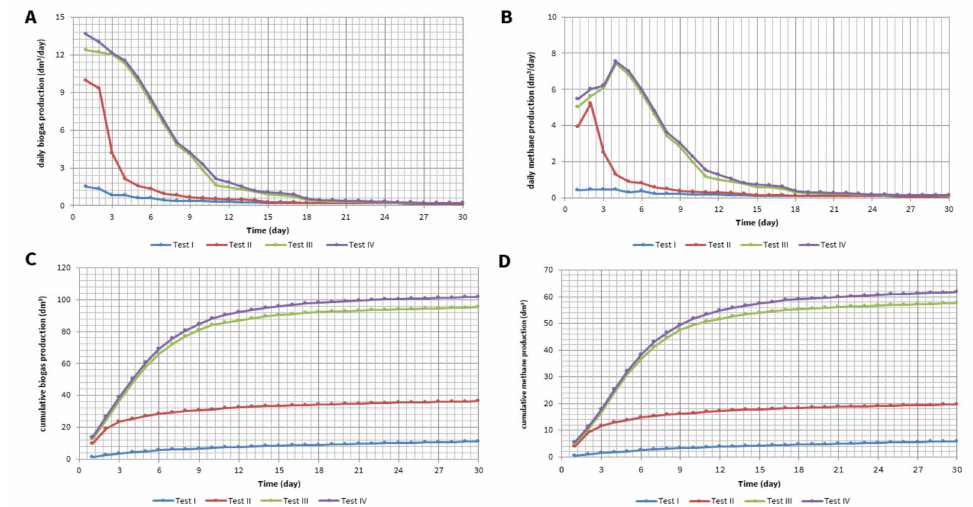
Figure 3. Daily production of: ( A ) biogas; ( B ) methane and accumulation curves of: ( C ) biogas; ( D ) methane production.